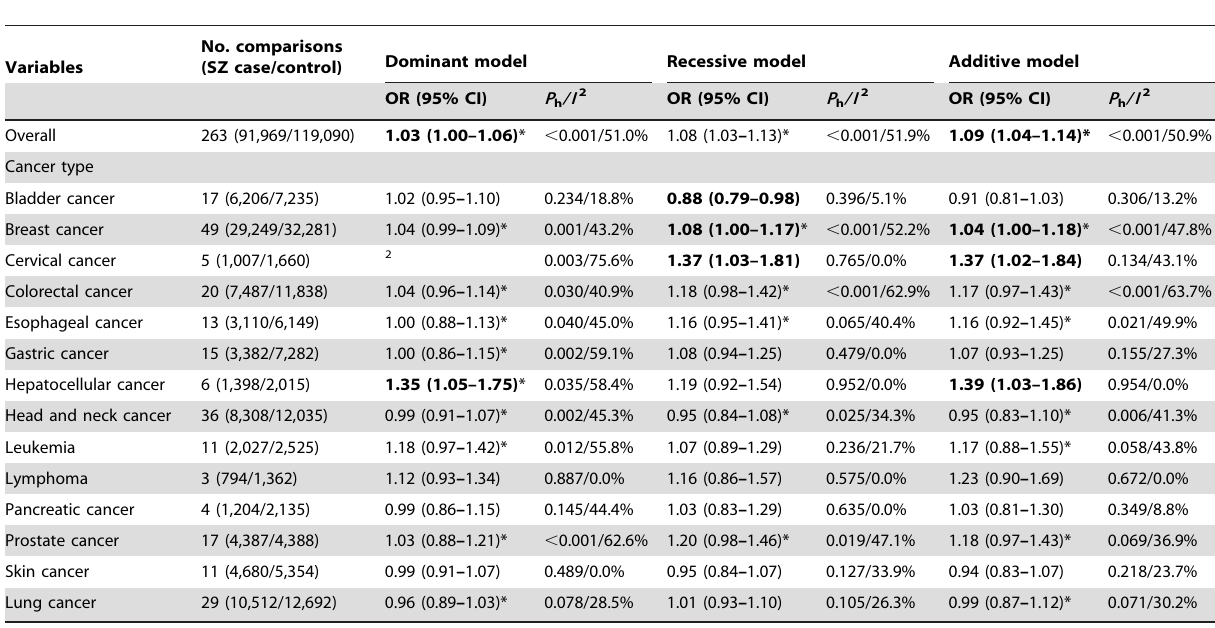
Table 6. Summary ORs (95% CI) and value of the heterogeneity of XRCC1 Arg399Gln polymorphism under different genetic models according to studies with a minimum of 200 participants on cancer risk 1 .